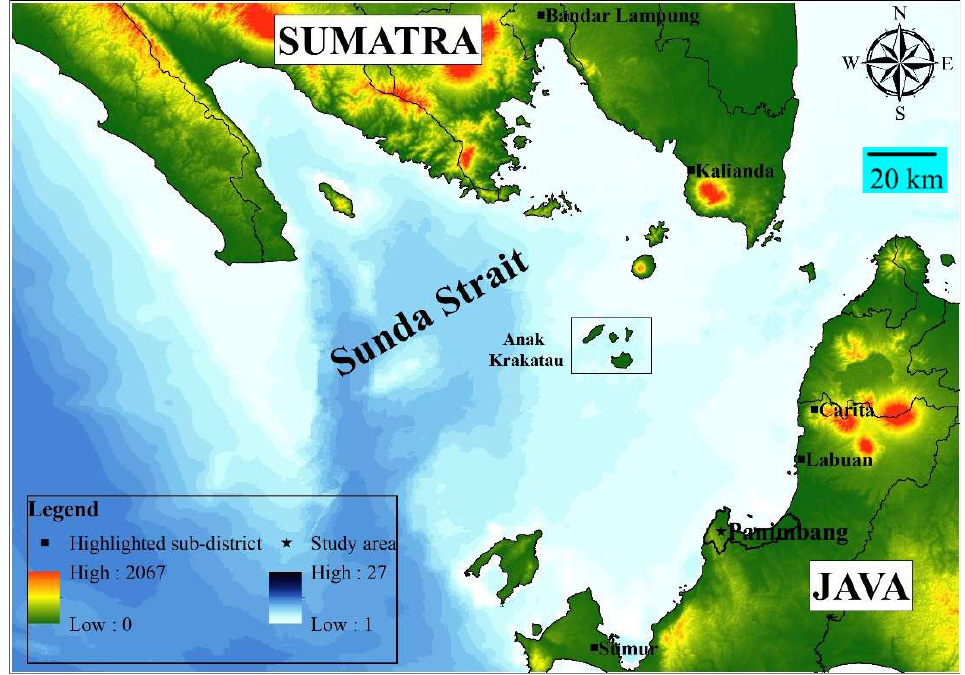
Figure 1. Location of Anak Krakatoa in the Sunda Strait between Java and Sumatra Islands, Indo-